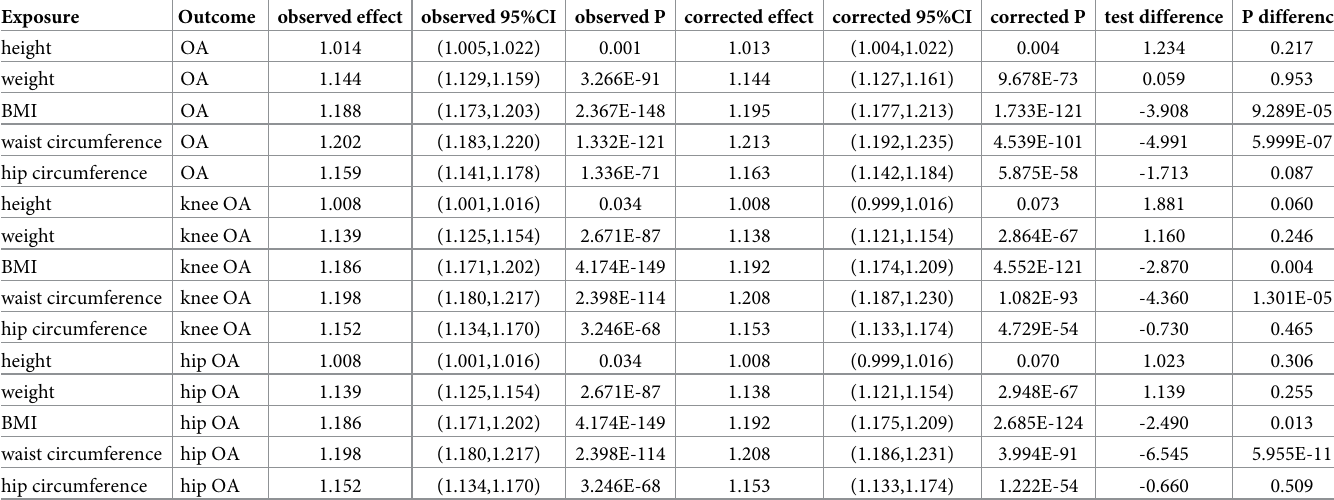
Table 2. Results of MR analyses using the MRlap